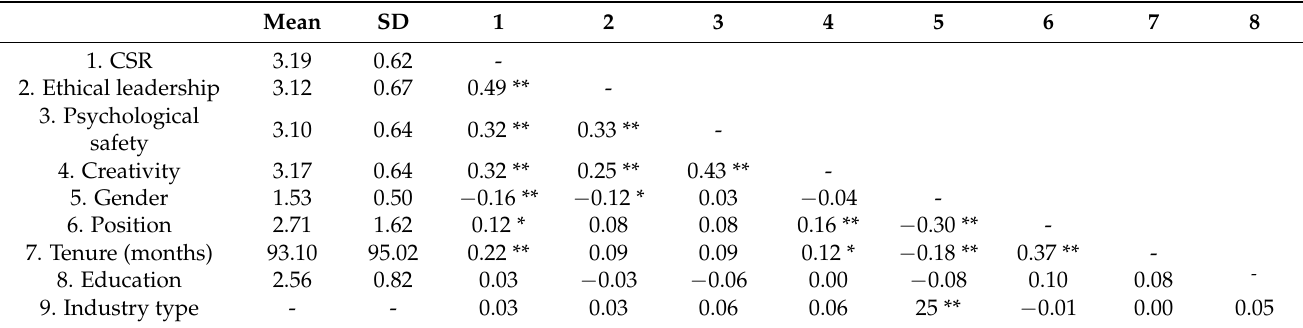
Table 2. Means, standard deviations, and intercorrelations of